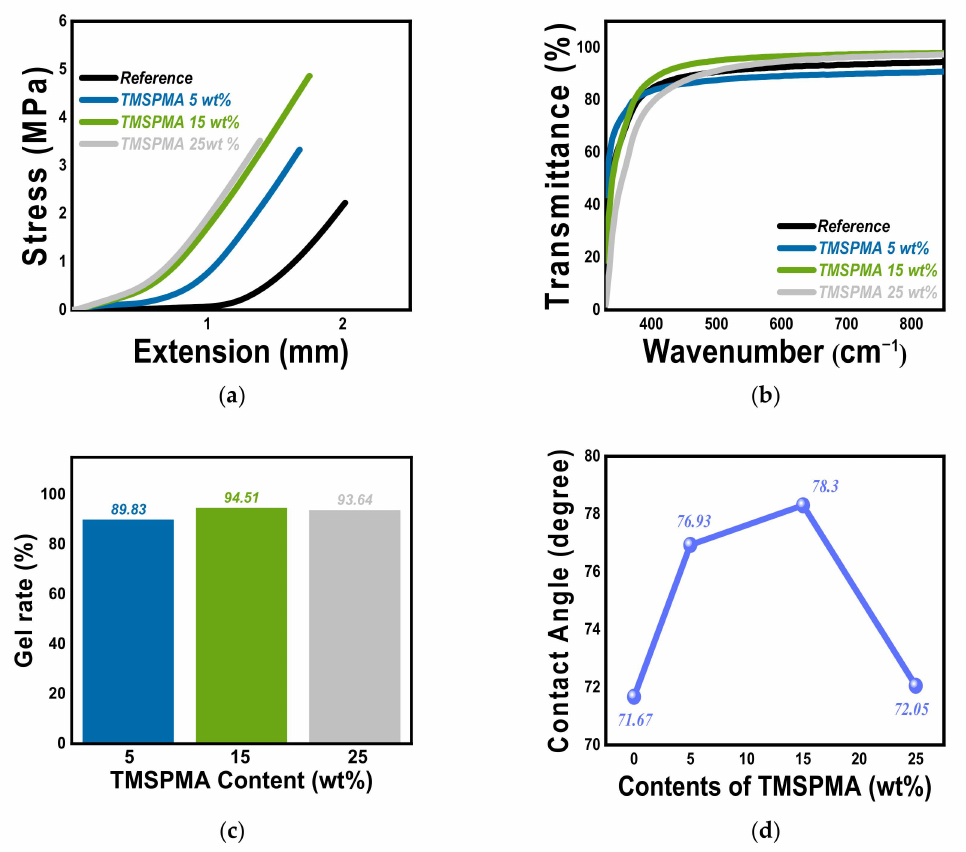
Figure 2. Properties of binders as a function of TMSPMA content (0 wt%, 5 wt%, 15 wt%, and 25 wt%): ( a ) stress–extension curves of binders, ( b ) UV transmittances (%) of binders; ( c ) gel rate (%) of binders injected with THF; ( d ) contact angle (degree) with water of